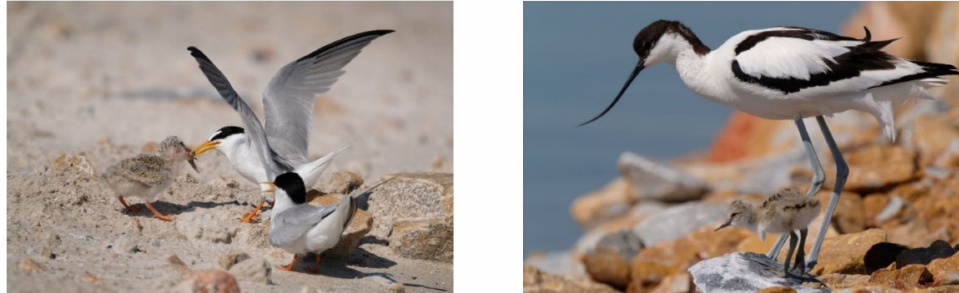
Figure 8. Little tern ( left ) and avocet ( right ) breeding colony (Source: Antonio Zamora L ó